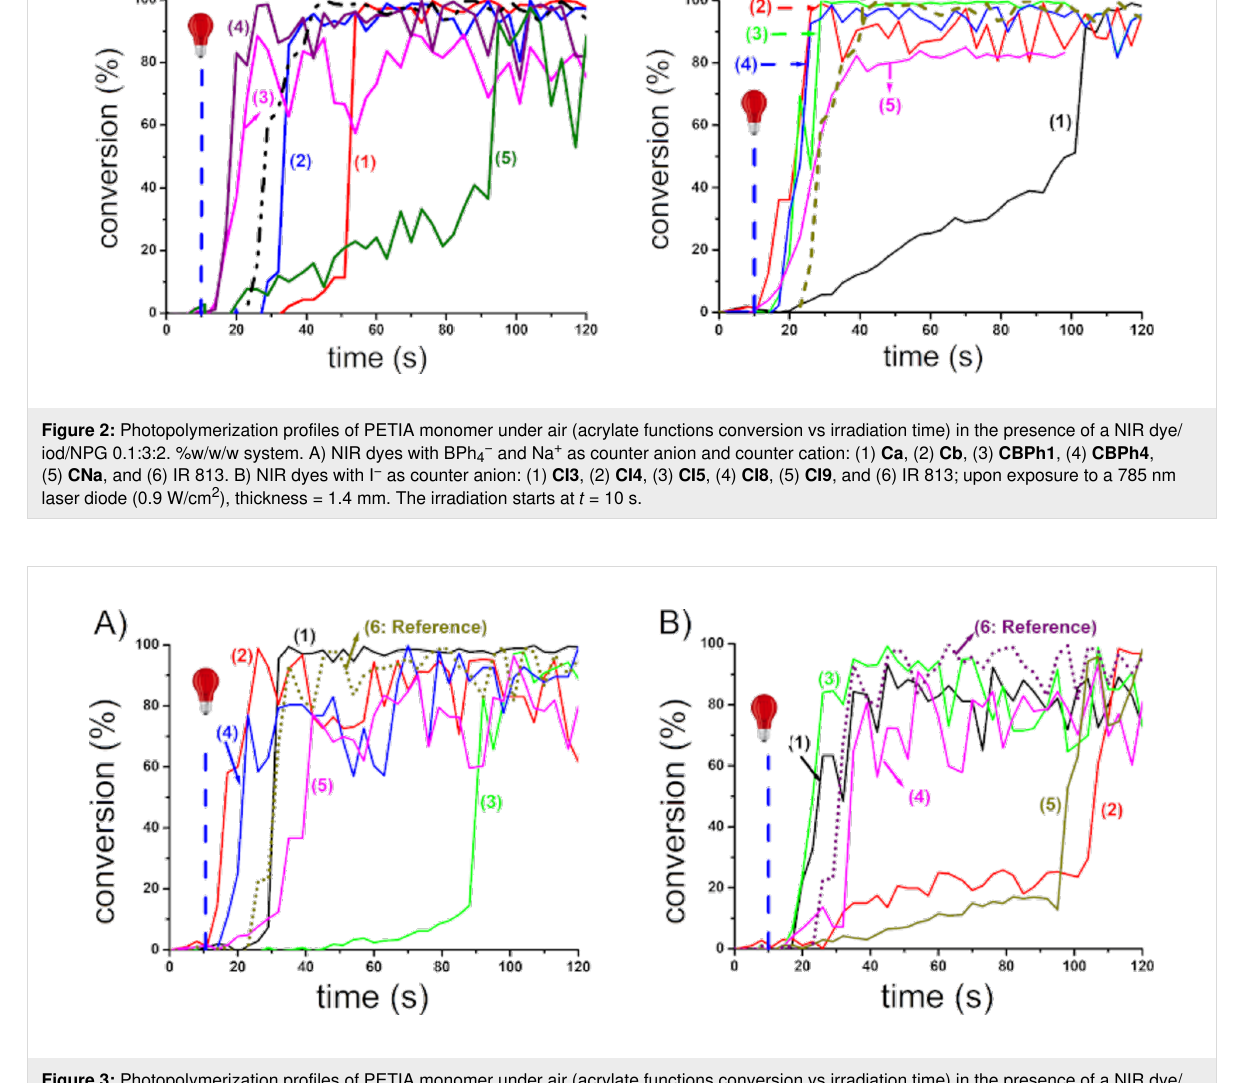
Figure 3: Photopolymerization profiles of PETIA monomer under air (acrylate functions conversion vs irradiation time) in the presence of a NIR dye/ iod/DABA 0.1:3:2, %w/w/w system. A) NIR dyes with BPh 4 − and Na + as counter anion and counter cation: (1) Cb , (2) CBPh1 , (3) CBPh3 , (4) CBPh4 , (5) CNa , and (6) IR 813. B) NIR dyes with I − as counter anion: (1) CI1 , (2) CI3 , (3) CI5 , (4) CI9 , (5) CI10 , and (6) IR 813; upon exposure to a 785 nm laser diode (0.9 W/cm 2 ), thickness = 1.4 mm. The irradiation starts at t = 10